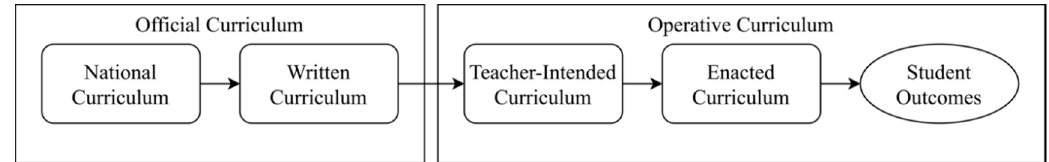
Figure 1. Korean mathematics teachers’ curriculum use (Adapted from [23] (p. 709)).